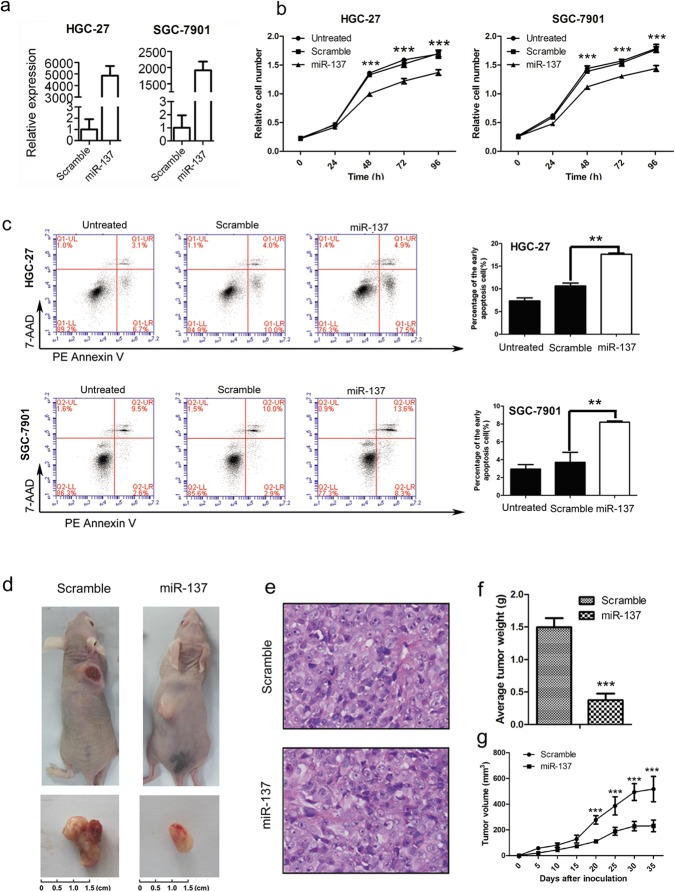
Overexpression of miR-137 inhibits gastric cancer cell proliferation.
A. Real-time PCR was performed to detect the miR-137 expression in HGC-27 and SGC-7901 cells treated with miR-137 mimic or scramble mimic. B. Growth of HGC-27 and SGC-7901 cells was shown after transfection with miR-137 mimic or scramble mimic or no transfection. The growth index was assessed at 0, 1, 2, 3 and 4 days. The bars represent the mean ± SD of three independent experiments (*** means P< 0.001). C. HGC-27and SGC-7901 cells were stained with PE Annexin V and 7-AAD 72 h after treatment with miR-137mimics or scramble. Early apoptotic cells are shown in the right quadrant. D. Representative figure of in vivo experiments. The tumor in miR-137 overexpression group is much smaller than the scramble. E. HE staining of mice tumor. F/G. Tumor volume and weight were calculated and all data are shown as mean ± SD. These results showed that both the tumor volume and weight was significantly reduced by miR-137 overexpression. These result verified that the miR-137 overexpression can suppress tumor growth in vivo (*: p<0.05;**: p<0.01; ***:p<0.001).